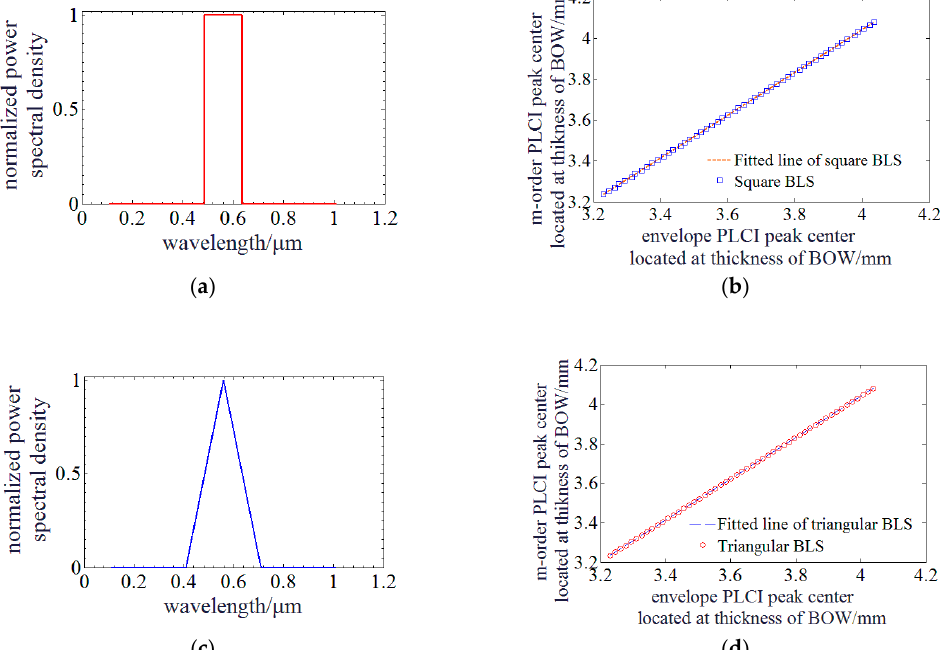
Figure 4. Simulation of PLCI for MADM with a BLS of square and triangular profile: ( a ) The profile of the square BLS; ( b ) Relationship between envelope and zero ‐ order PLCIF peak center when BLS is in square profile; ( c ) The profile of the triangular BLS; ( d ) Relationship between envelope and zero ‐ order PLCIF peak center when BLS is in triangular profile.